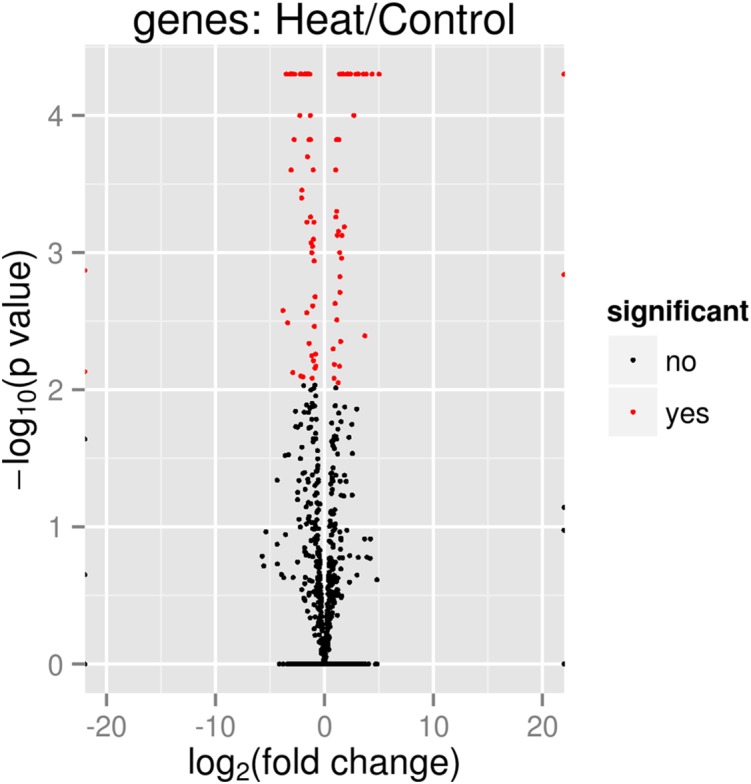
Volcano plot of P. aeruginosa PAO1 gene expression pattern.In the volcano plot, the red dot shows significant genes below or at alpha = 0.05; Control: exposure to 37 °C; Heat: exposure to 46 °C.